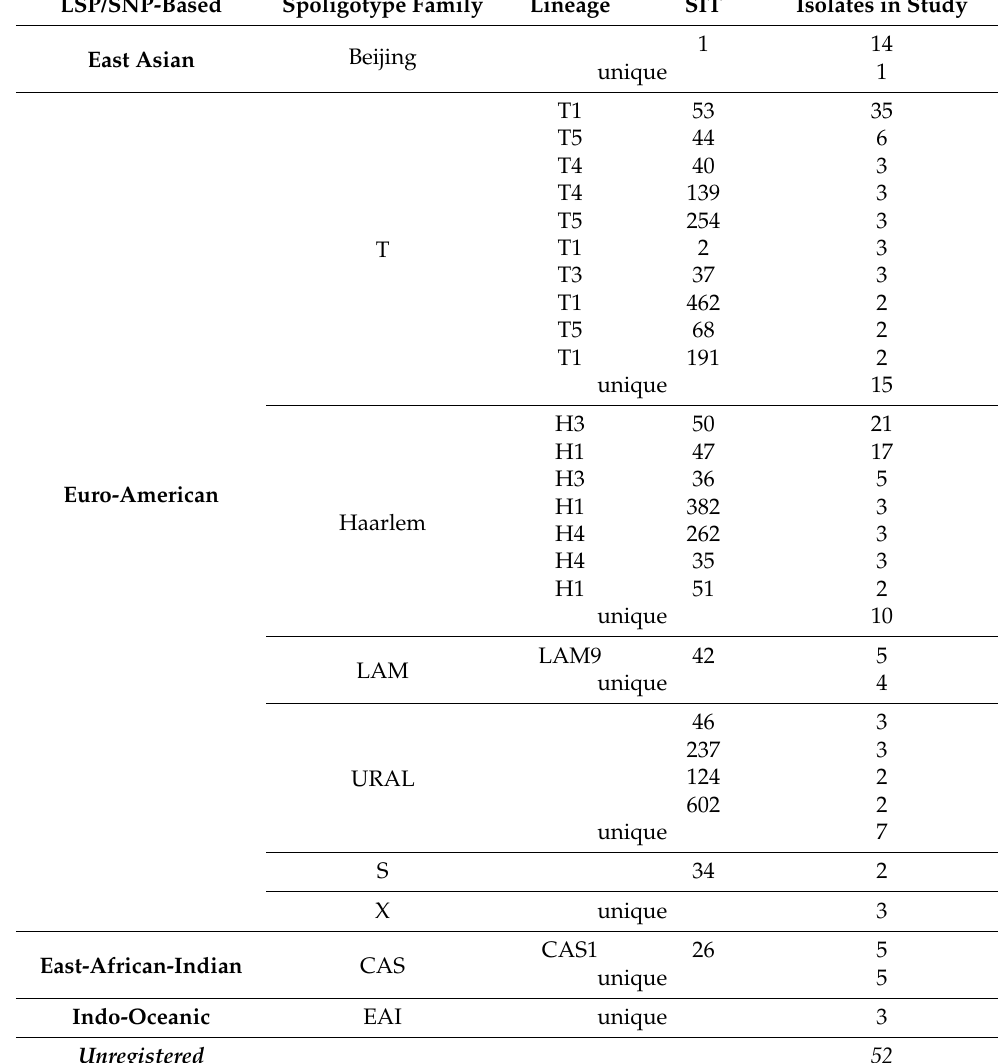
Table 6. Prevalence of the most common spoligotypes of sensitive strains of Mycobacterium tuberculosis in Poland in 2020 (n =